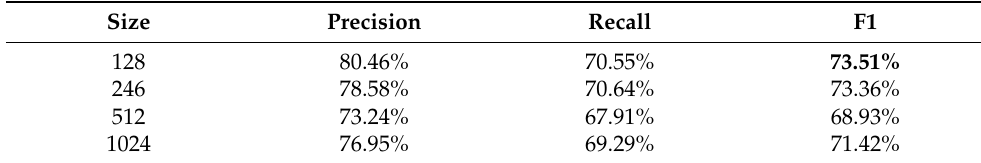
Table 4. Comparison of different sizes of hidden layer.